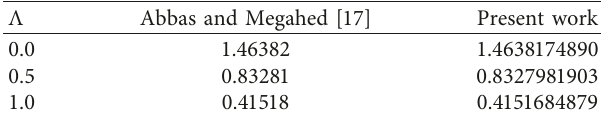
Table 1: Comparison of (− 1/2 )